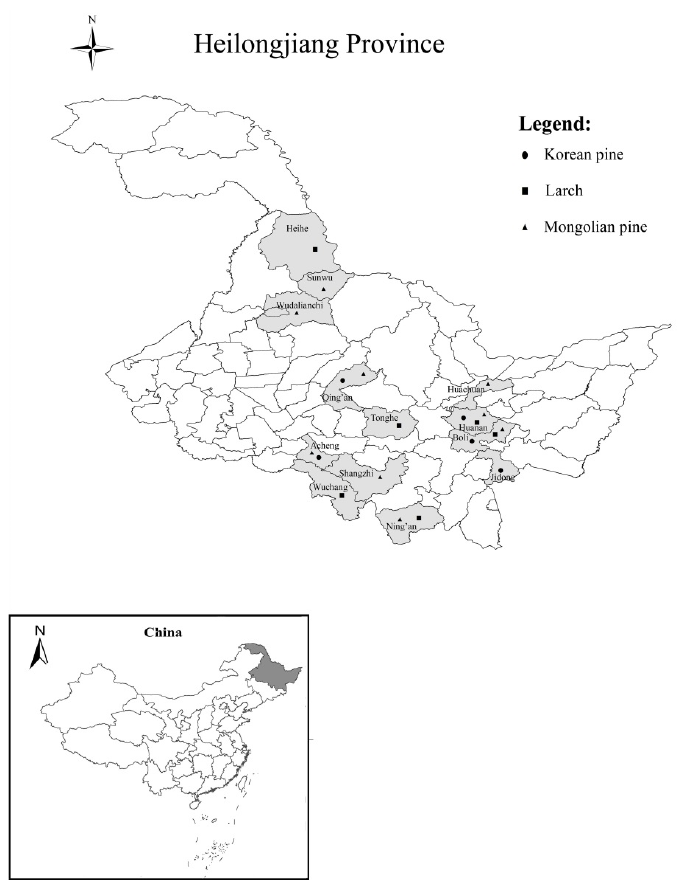
Figure 1. Geographical location of study area and plot distribution in Heilongjiang province of China. Table 1. Characteristics of forest types from which the sample trees were selected. Table 1. Characteristics of forest types from which the sample trees were